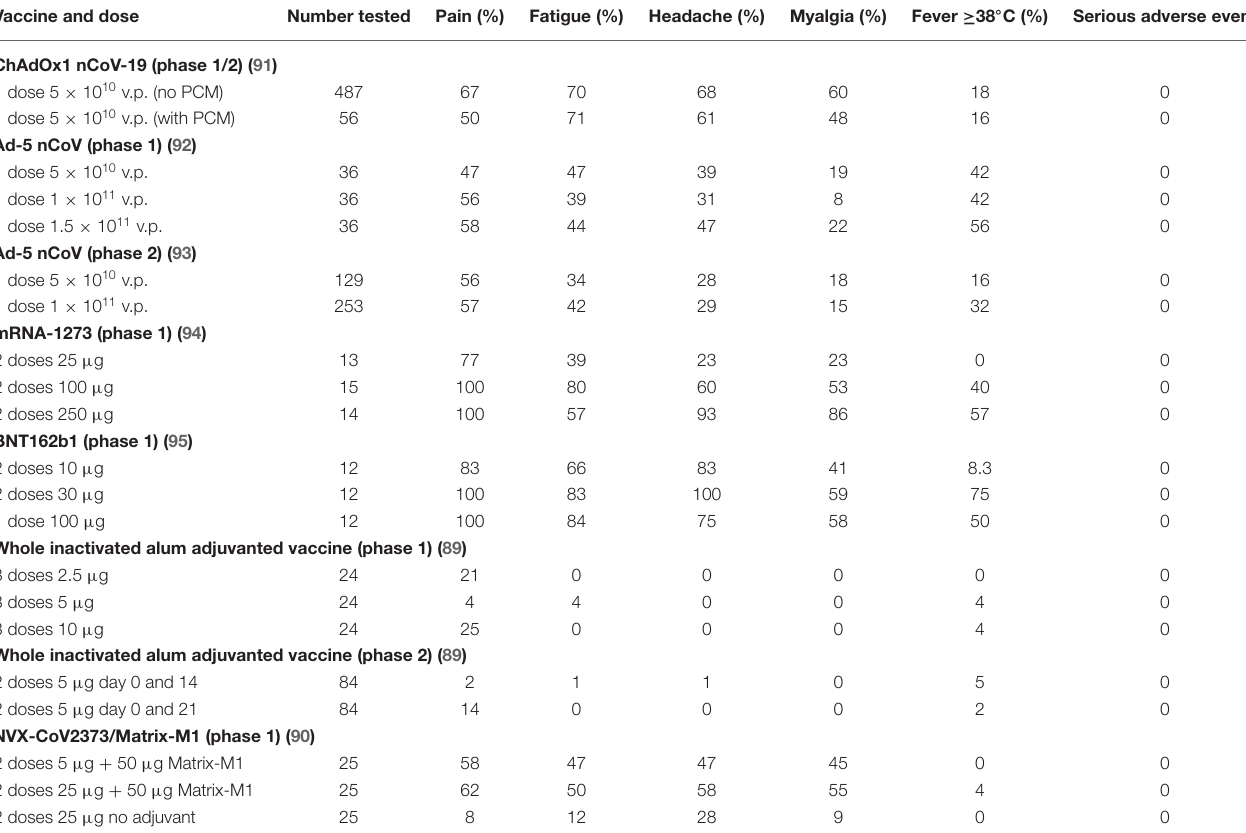
TABLE 5 | Summary of phase 1/2 safety reporting results for ChAdOx1 nCoV-19, Ad5-nCoV, mRNA-1273, and BNT-162. Vaccine and